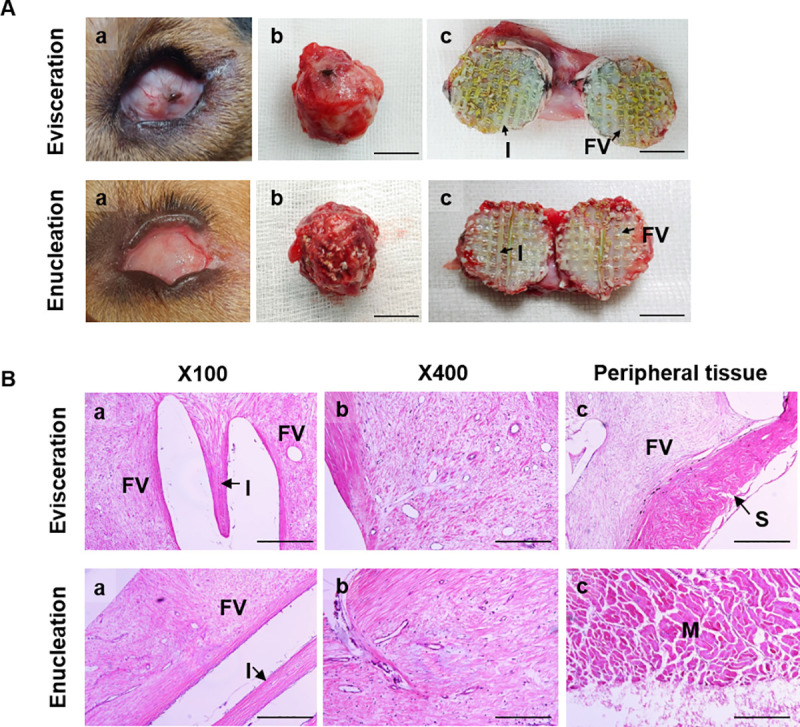
Postoperative findings 6 months after surgery.The results showed no evidence of inflammation and rejection (A, a). The morphology of implants were well maintained (A, b), moreover, fibro-vascular tissue (FV) ingrowth from the host was formed into the implants (I) (A, c). Bar = 1cm. In histology, fibro-vascular tissue was shown in the porous structure of the implants (B, a and b). Numerous connective tissues and vessels were shown. Also, no inflammation and rejection was shown in the peripheral tissues such as sclera (S) and muscle (M) near the implants (B, c). Bar = 100μm.